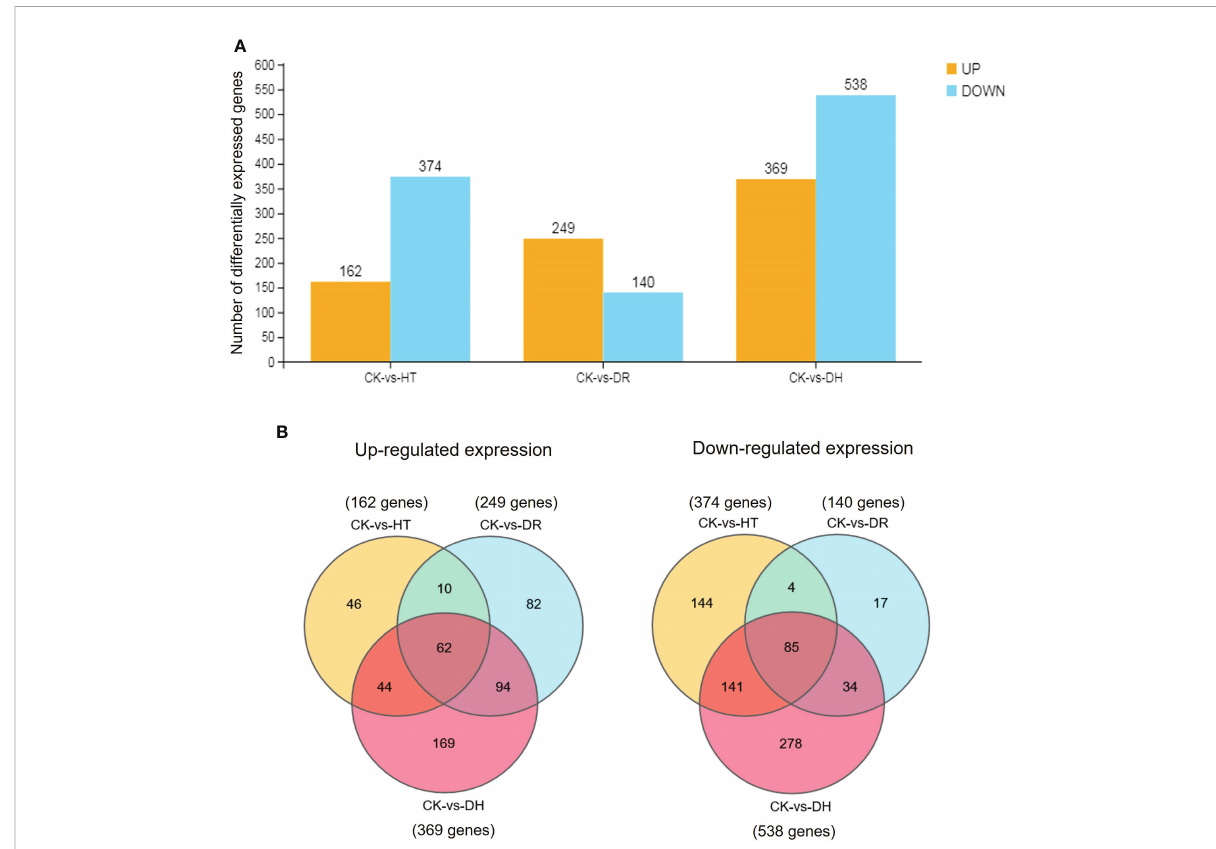
FIGURE 1 Comparisons of DEGs. (A) Number of DEGs under all stress conditions. DEGs were de fi ned by FDR <0.05 and |log 2 of fold change (FC)| >1. Yellow indicates up-regulation and blue indicates down-regulation. (B) Venn diagram illustrating the up-regulated (left side) and down- regulated (right side) genes under HT, DR, and DH stresses. CK, control; HT, heat stress; DR, drought stress; DH, drought and heat